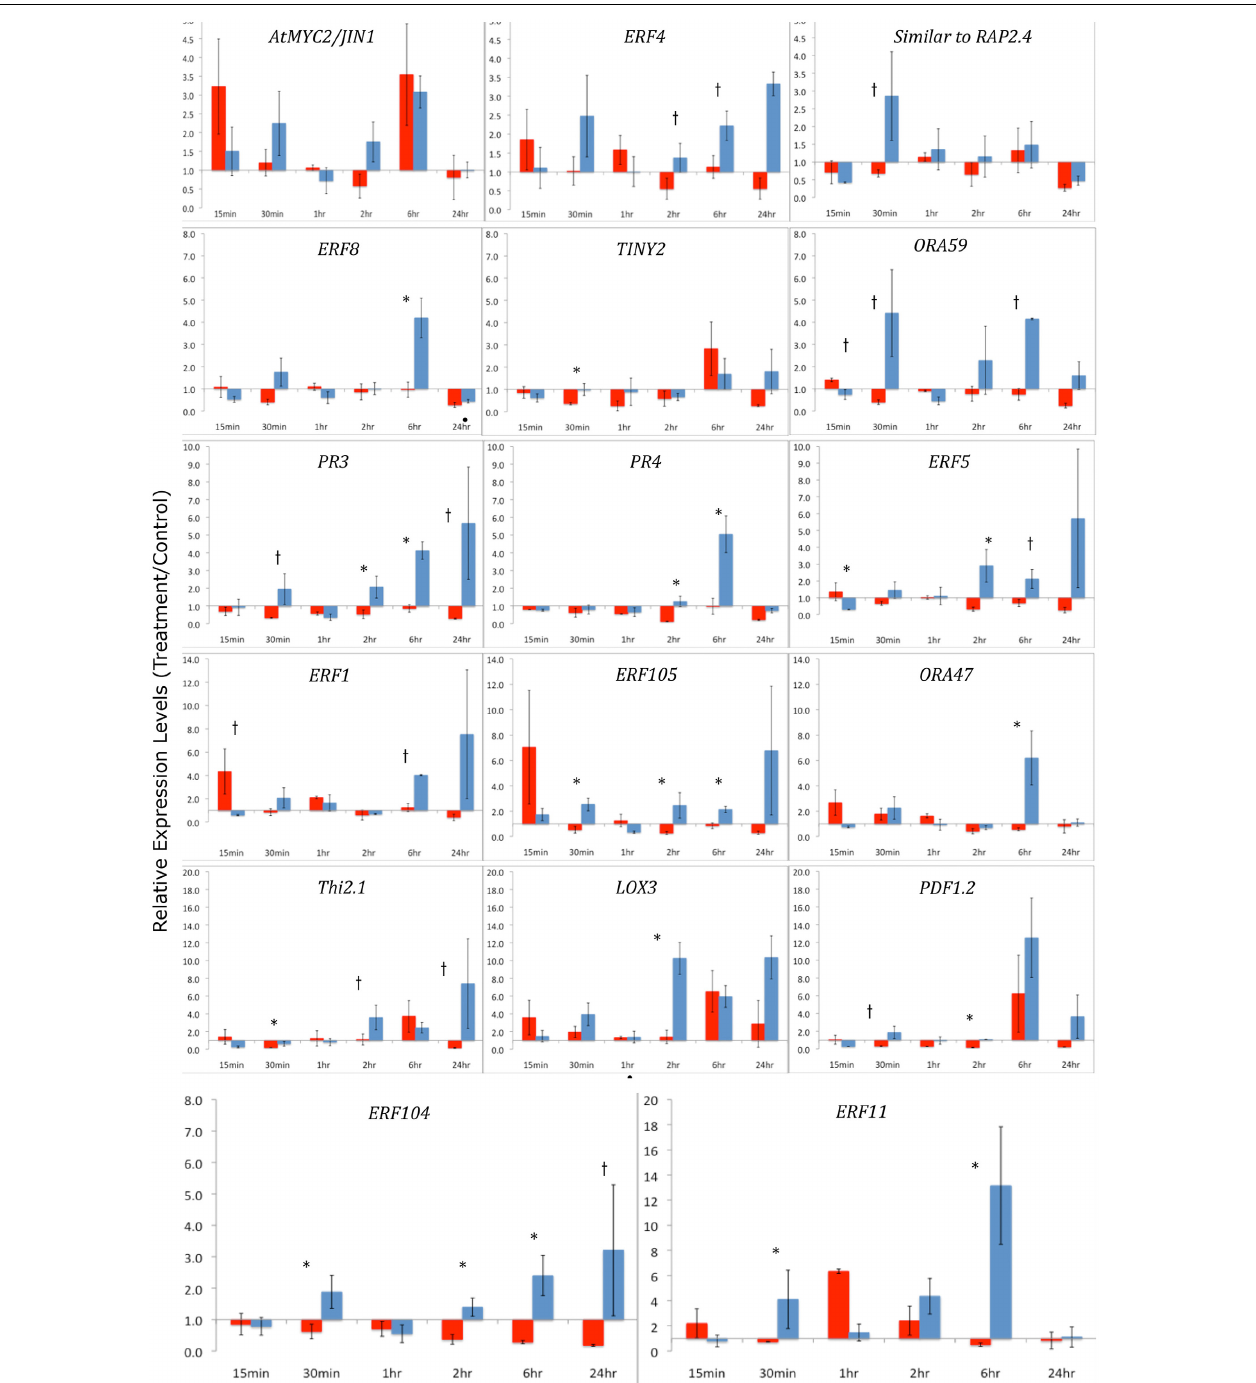
FIGURE 4 | qRT-PCR of ERF Transcription Factors and defense-related genes after Herbivory-Y-axes represent fold changes of treatment/controls. Arabidopsis leaf tissue was collected 15min, 30min, 1h, 2h, 6h, and 24h after herbivory by S. exigua or P. rapae caterpillars. Red bars indicate Pieris treatments and blue bars represent Spodoptera treatments. qRT-PCR data were normalized to RNA quantity and the expression of an exogenous LUC spike.